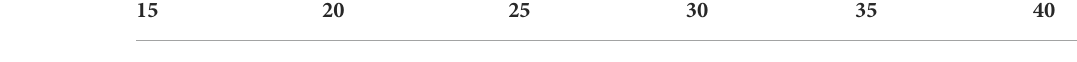
TABLE 2 Comparison of different concentration of the O – methoxyamine HCl in pyridine (mg/ml) based on the repeatability of 75 MDMs detected in both types of samples, in the table was presented number of MDMs with RSD for plasma/serum ≤ 10% – 30% and above 30%. RSD